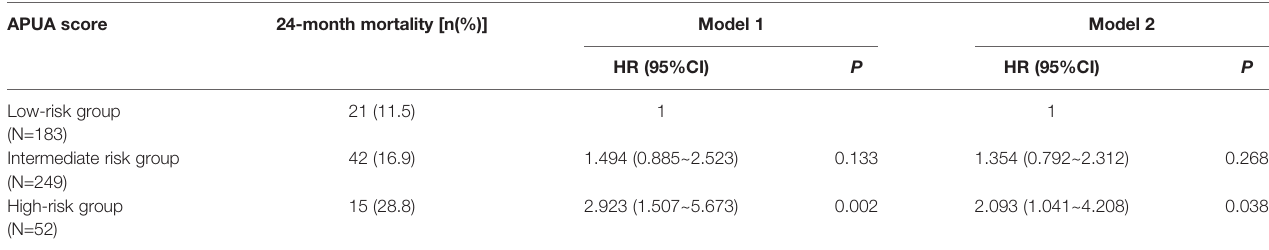
Low-risk group (N=183) Intermediate risk group